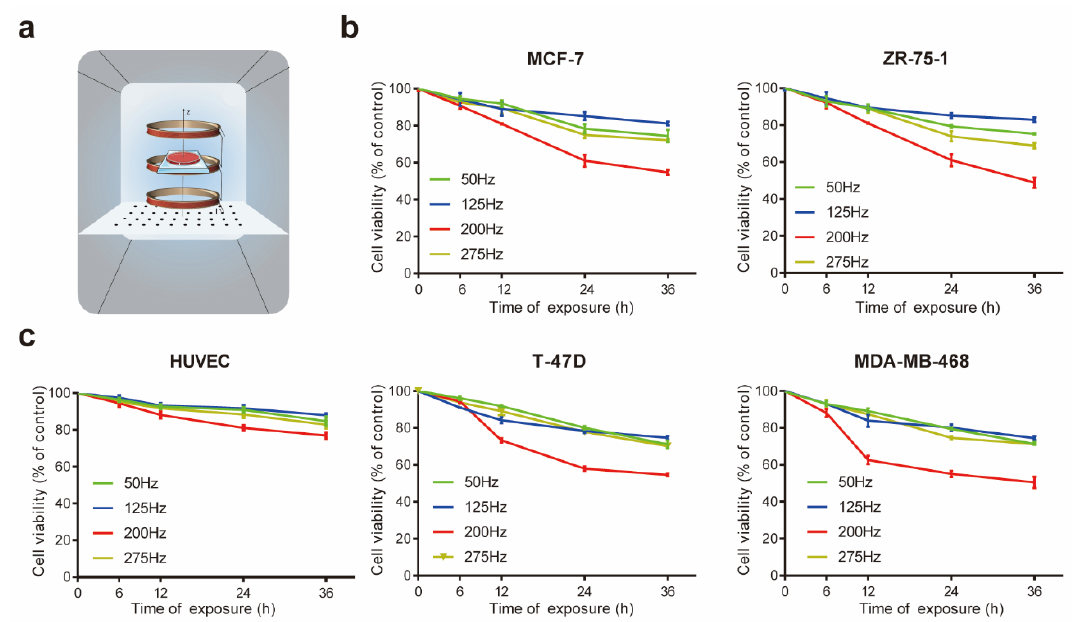
Figure 1. Low frequency magnetic fields inhibited the viabilities of breast cancer cells. ( a ) A three coil Helmholtz system is settled in the cell incubator to provide a magnetic field (MF) condition for cell culture. ( b ) and ( c ) 3-(4,5-dimethyl-2-thiazolyl)-2,5-diphenyl-2-H-tetrazolium bromide (MTT)assay showed that low frequency MF inhibited the proliferation of MCF-7, ZR-75-1, T-47D and MDA-MB-468 cells in a time-dependent manner, but had limited toxicity in HUVECs. Data were presented as mean ± standard deviation (SD); n = 3.